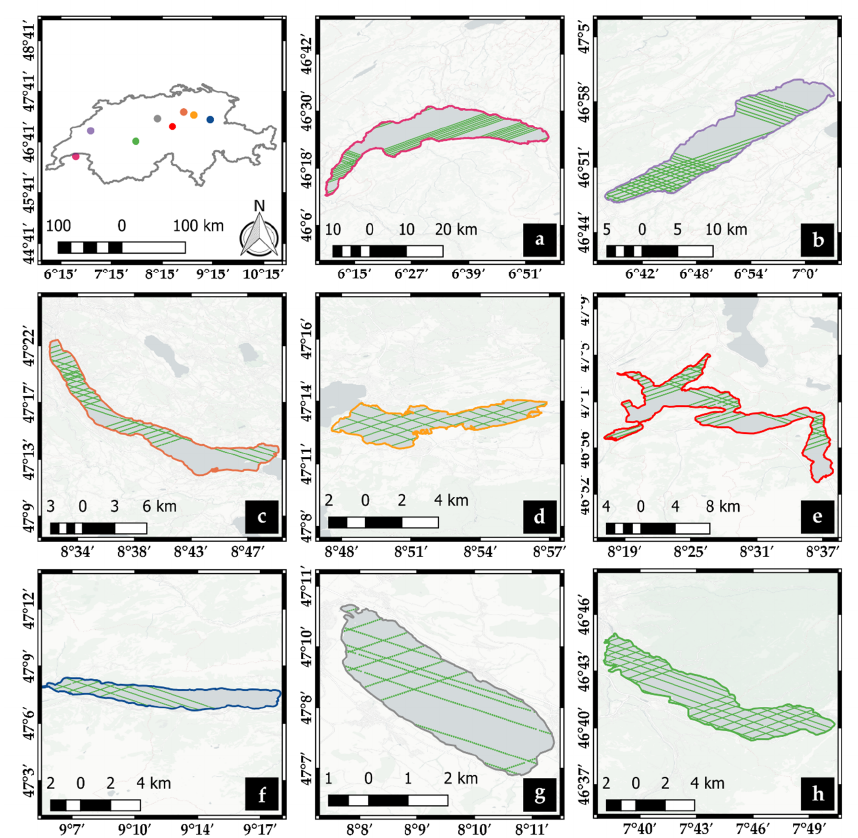
Figure 1. Location of the studied lakes in Switzerland (top left). ( a ) : Geneva; ( b ): Neuchâtel; ( c ): Zürich; ( d ): Obersee (Zürich); ( e ): Lucerne; ( f ): Walensee; ( g ): Sempach; ( h ): Thun. The green transects represent the GEDI tracks over each lake. Table 1. Global Ecosystem Dynamics Investigation (GEDI) acquisition dates between April and June 2019 and available GEDI shot count over the studied lakes. The star (*) indicates that the average level of water was available for 2018, not 2019.